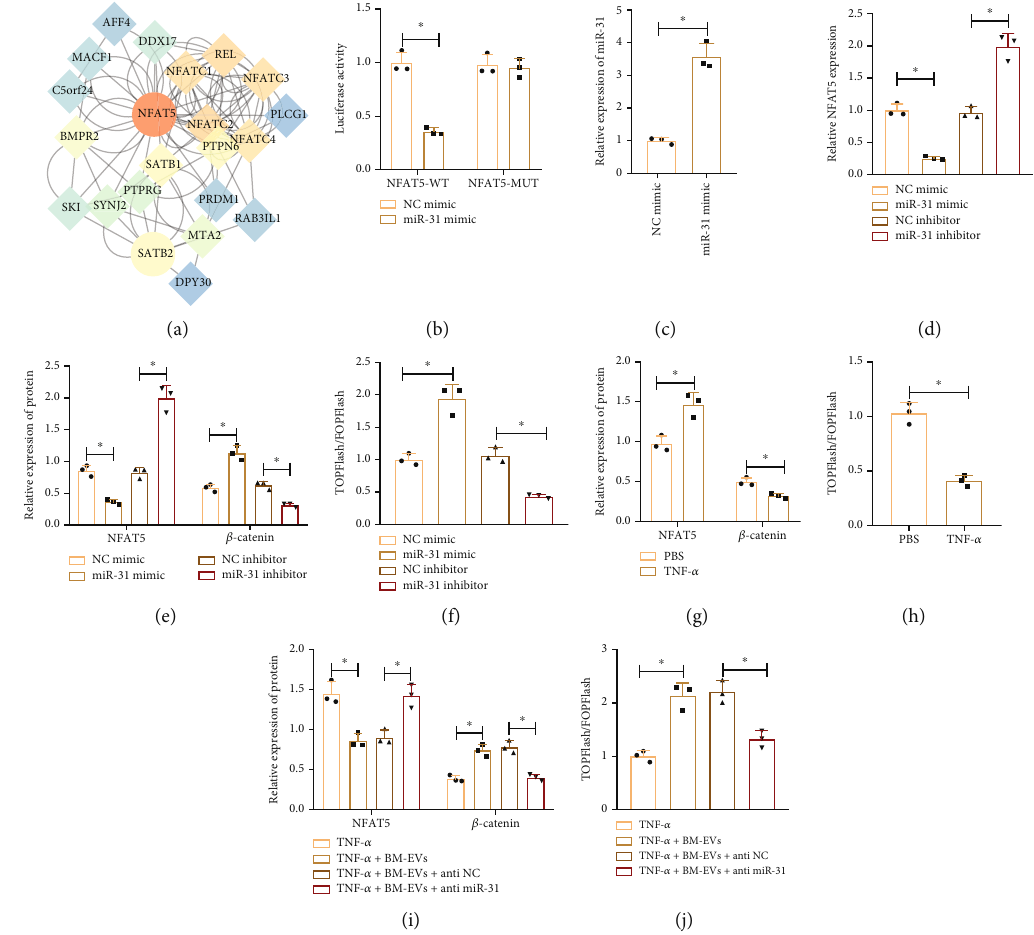
Figure 6: miR-31 targets NFAT5 and activates the Wnt/ β -catenin pathway in NPCs: (a) a PPI network of the genes related to the key downstream genes constructed through GeneMANIA; (b) binding of miR-31 to NFAT5 in 293T cells determined by dual luciferase reporter assay; (c) expression of miR-31 in NPCs after transfection with miR-31 mimic or miR-31 inhibitor determined by RT-qPCR; (d) expression of NFAT5 in NPCs after transfection with miR-31 mimic or miR-31 inhibitor determined by RT-qPCR; (e) expression of NFAT5 and β -catenin in NPCs after transfection with miR-31 mimic or miR-31 inhibitor determined by Western blot; (f) the transcription activity of TCF/LEF in NPCs after transfection with miR-31 mimic or miR-31 inhibitor determined by TOPFlash; (g) protein expression of NFAT5 and β -catenin in TNF- α -treated NPCs determined by Western blot; (h) the transcription activity of TCF/ LEF in TNF- α -treated NPCs determined by TOPFlash; (i) expression of NFAT5 and β -catenin in TNF- α -treated NPCs cocultured with BMSCs-EVs or BMSCs-EVs+anti-miR-31 determined by Western blot; (j) the transcription activity of TCF/LEF in TNF- α -treated NPCs cocultured with BMSCs-EVs or BMSCs-EVs+anti-miR-31 determined by TOPFlash. ∗ p < 0 : 05 . Cell experiments were repeated three